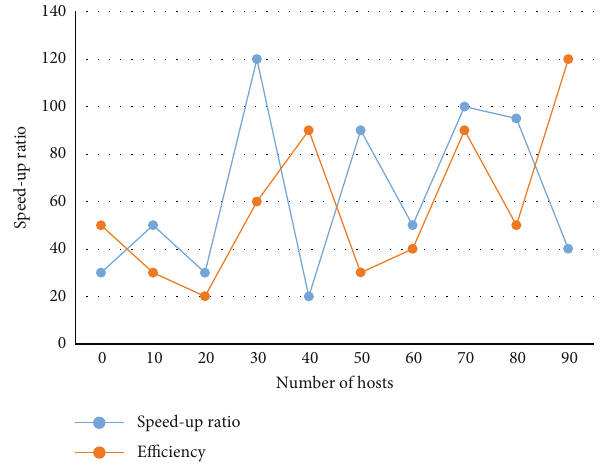
Figure 4: Trend diagram of experimental acceleration ratio of group intelligence